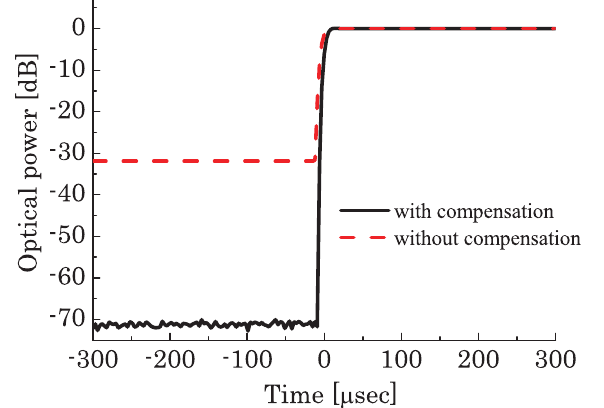
Figure 3. On-off-keying by an MZM with and without imbalance compensation